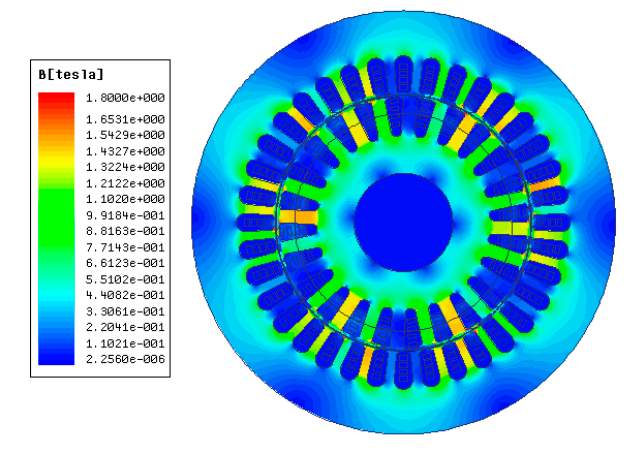
Figure 14. The phase current of the stator winding under no load.